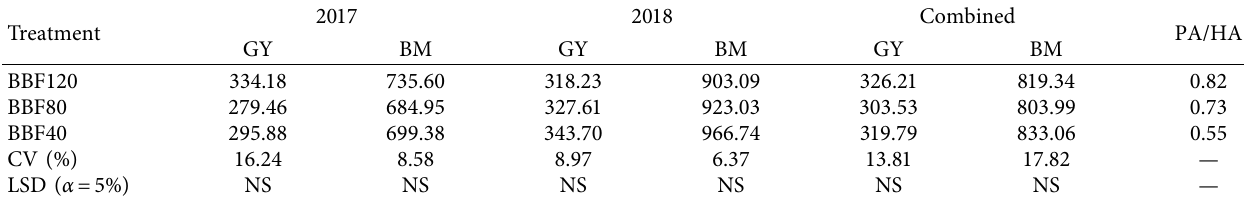
Table 4: Grain yield (g/m 2 ) and biomass (g/m 2 ) per productive area for each growing season and the proportion of productive area to harvestable